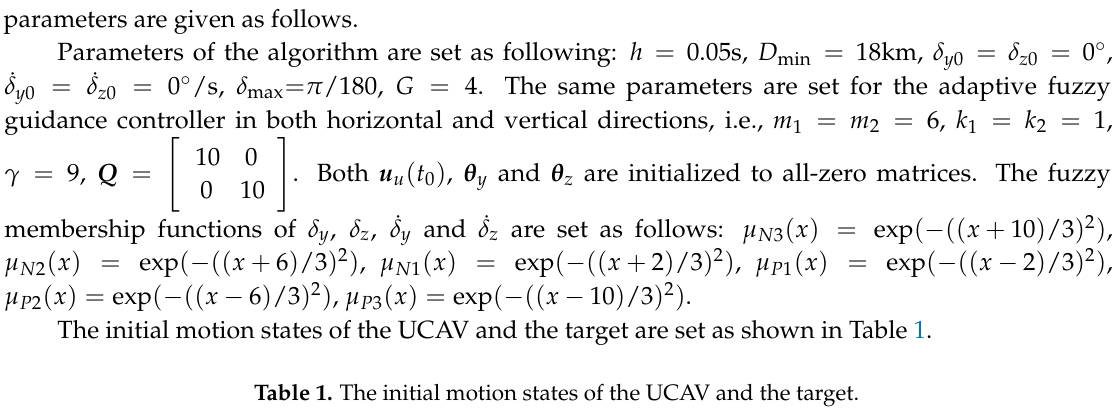
Table 1. The initial motion states of the UCAV and the target. x ( km ) y ( km ) z ( km ) v ( m/s ) θ ( rad ) φ ( rad ) UCAV 0 7 0 300 0 0 Target 60 5 0 300 0 π